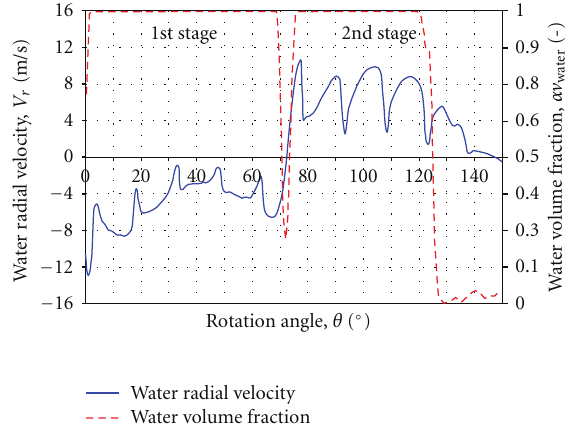
Figure 10: Water radial velocity and water volume fraction variations for a specific θ range along the outside runner diameter.